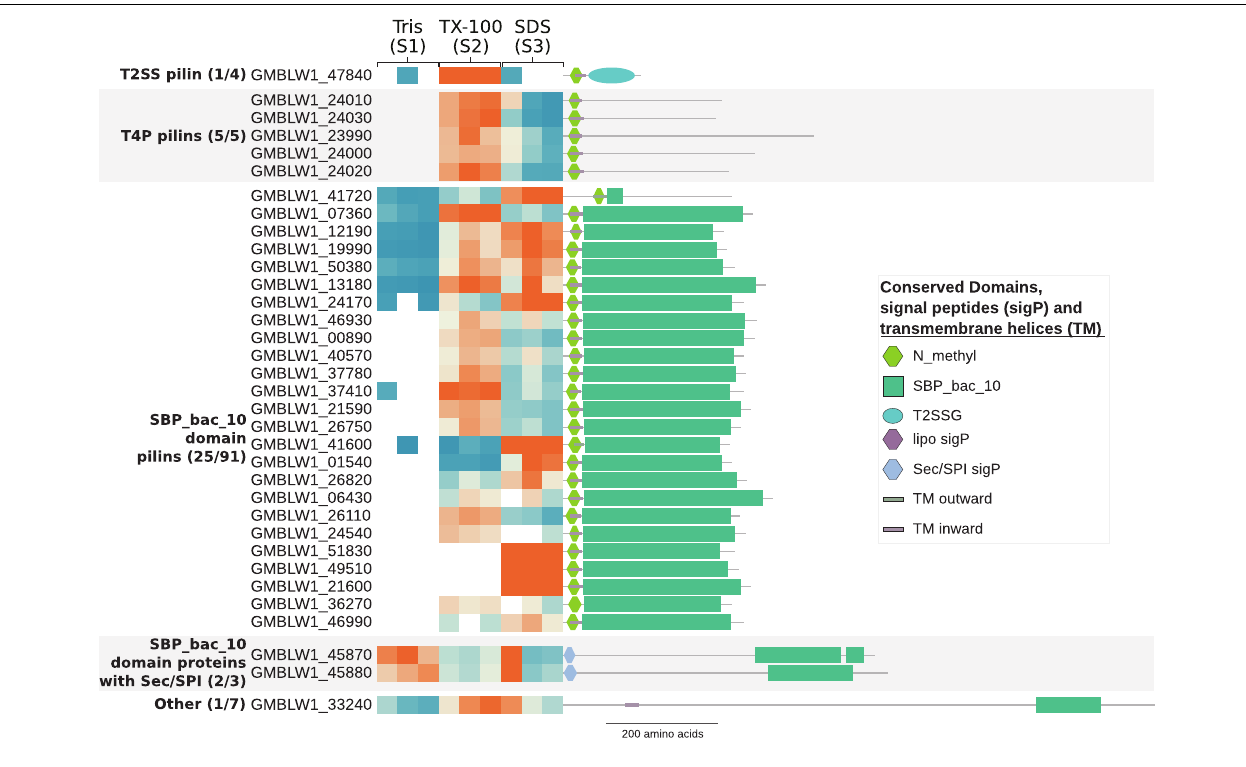
FIGURE 6 | Subcellular fractionation profiles and domain architectures of protein groups in T. immobilis with N_methyl prepilin cleavage motif and/or SBP_bac_10 Pfam domains. The numbers in parenthesis for each protein group represent the number of identified proteins out of the total number of predicted proteins in the group. The heatmap shows the relative abundance of the experimentally identified proteins (colored according to Figure 4 ) as a function of the respective subcellular fraction [Tris soluble (S1), Tris/TX-100 soluble (S2), and Tris/SDS soluble (S3)]. Signal peptides were predicted with SignalP-5.0 and transmembrane domains were predicted using Phobius